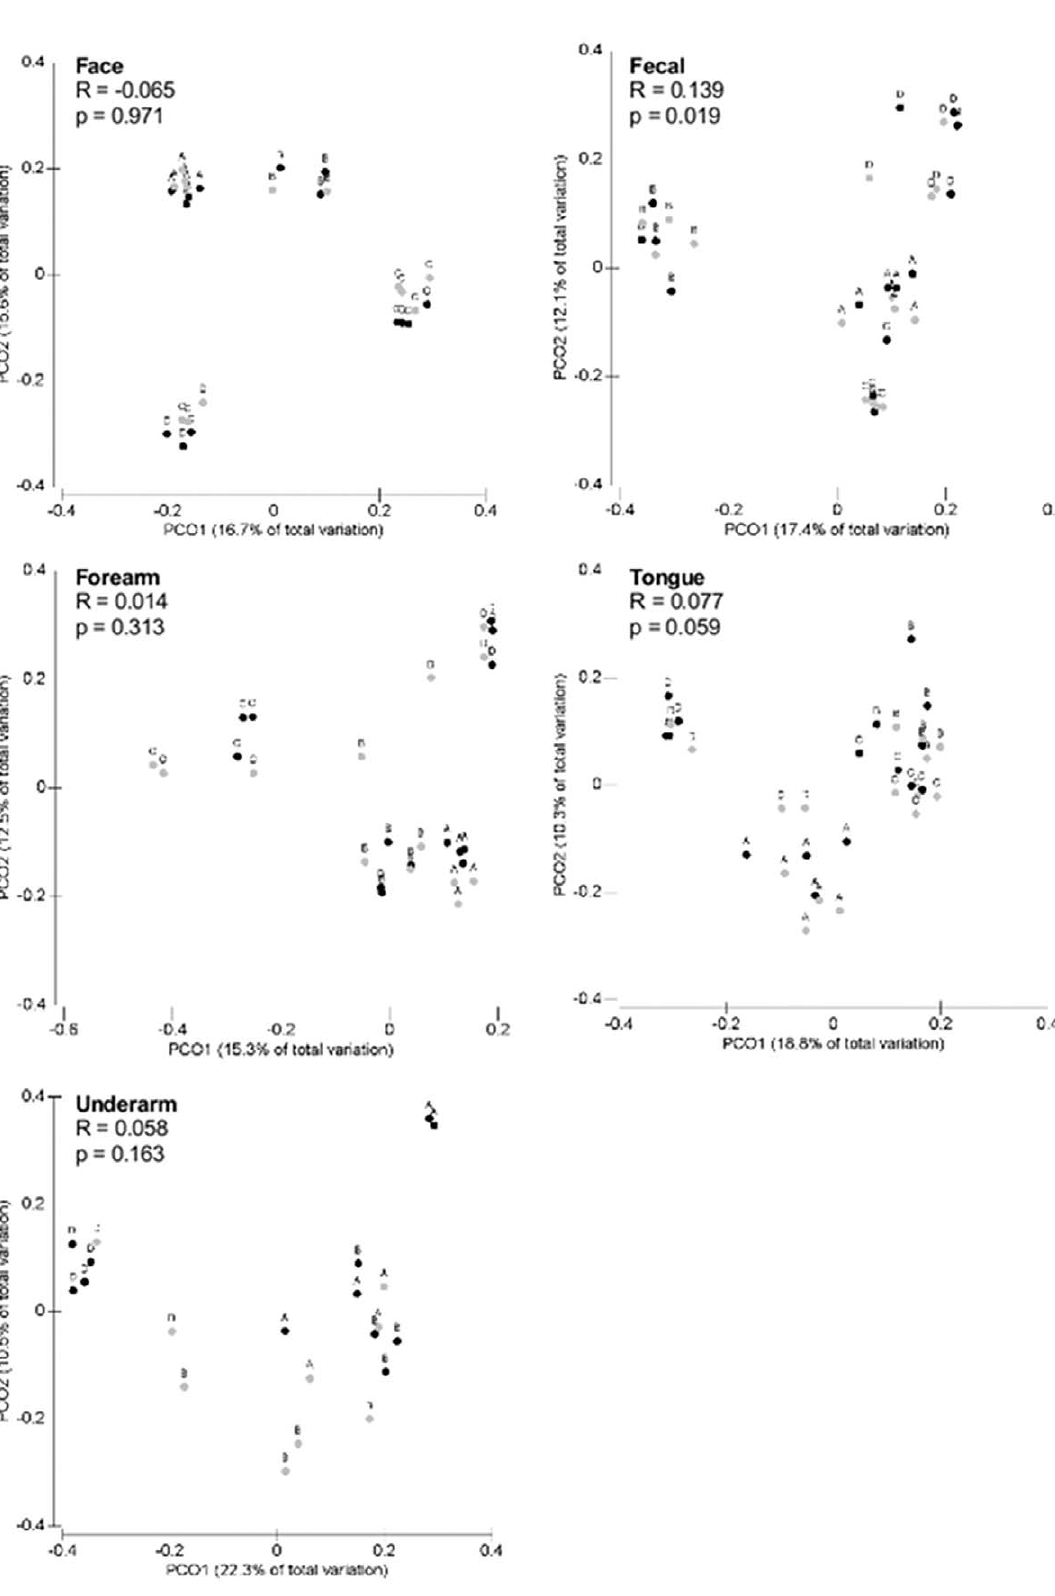
Figure 4. PCoA plots derived from unweighted UniFrac distances comparing the communities observed using the direct PCR (black circles) and standard extraction/purification (grey circles) protocols. Letters A–D denote individual participants. Results of the ANOSIM testing for statistical differences between methods across individuals are shown for each body habitat. Note that individual C was not included in the underarm analysis as sequences were not obtained for the direct PCR samples. doi:10.1371/journal.pone.0044563.g004 PLOS ONE |